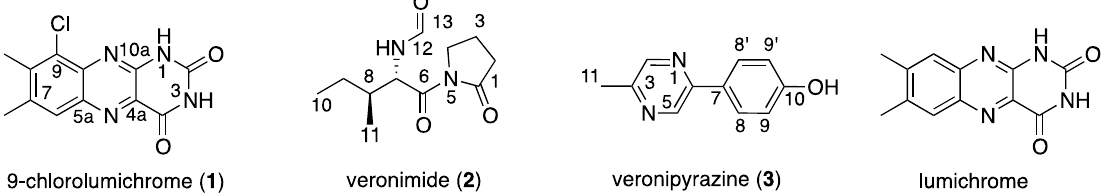
Figure 1. The new metabolites that were isolated from Aeromonas veronii strain A134.